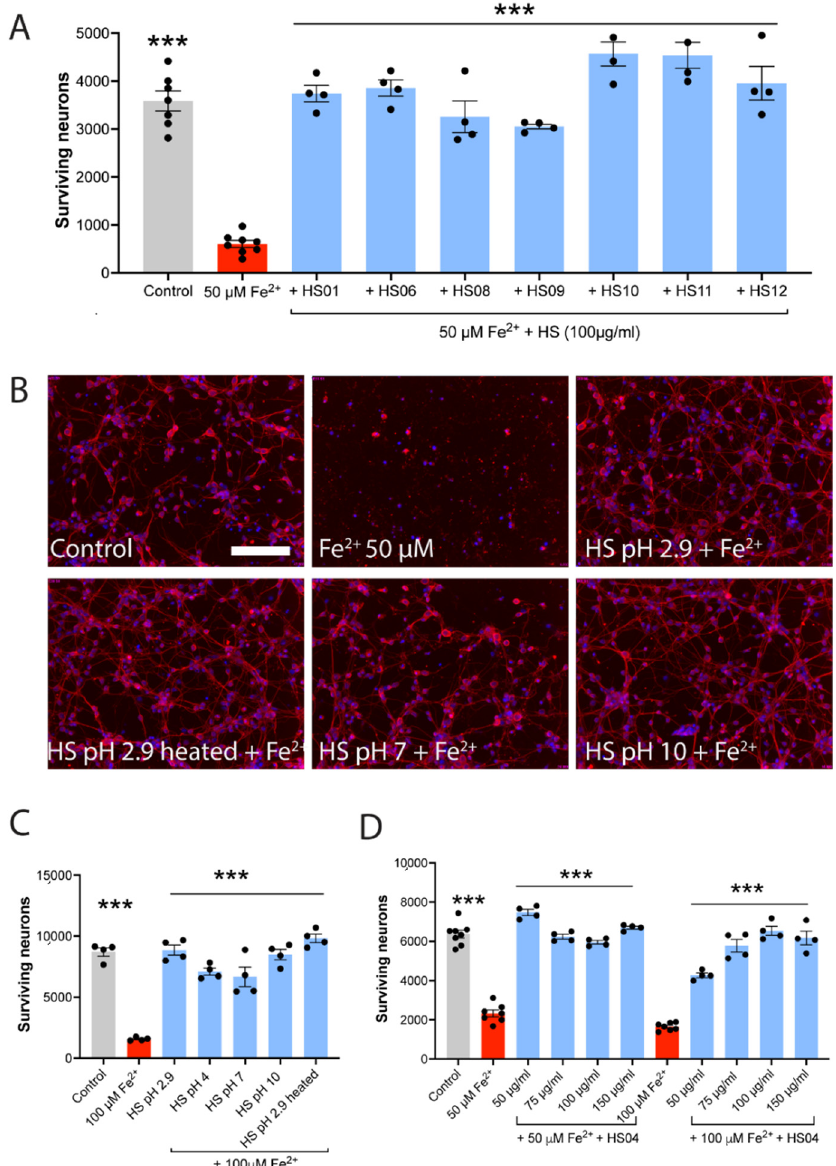
Figure 2. HS of varied pH protects against the iron-mediated killing of mouse neurons. ( A ) The killing of mouse neurons by iron is completely prevented by 7 different batches of HS extracts. All groups are different from iron alone: *** p < 0.001 (1-way ANOVA with Dunnett multiple comparisons). ( B , C ) The protection of mouse neurons against iron toxicity by HS occurs despite the pH of HS being altered or HS being heated. Neurons are detected by Tuj1 staining (red), and all cells are labeled with DAPI (blue). The scale bar in the control group is identical across all 6 panels and represents 100 µ m. Values are mean ± SEM, with each dot representing a well. ( D ) Complete protection against iron neurotoxicity occurs from 50 to 150 µ g/mL HS when the iron concentration is 50 µ M. When FeSO 4 is raised to 100 µ M, the 50 µ g/mL HS is less but still highly effective in ameliorating neuronal death. *** p < 0.001 (1-way ANOVA with Dunnett multiple comparisons) compared to